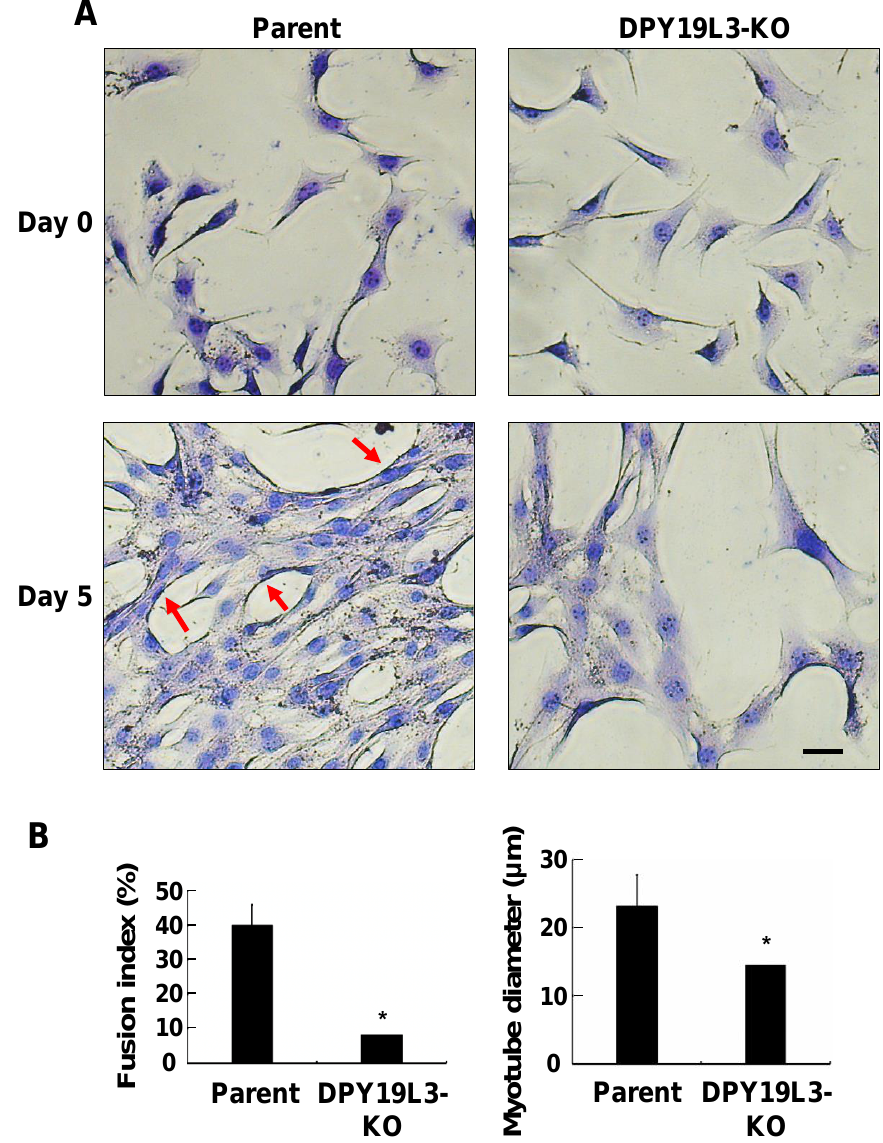
Figure 3. Inhibition of myogenic differentiation in C2C12-DPY19L3-KO cells. ( A , B ) Effect of depletion of the DPY19L3 gene on myogenic differentiation. C2C12 (parent) and C2C12-DPY19L3-KO (DPY19L3-KO) cells were cultured in GM, and the culture medium was changed from GM to DM for 0 (upper) or 5 days (lower). The cells were visualized with May–Grünwald Giemsa stain and photographed. Red arrow markers indicate myotubes which contain 3 or more nuclei. Bar, 100 µ m ( A ). Fusion index and myotube diameter were calculated ( B ). Data represent mean ± standard error (* p <